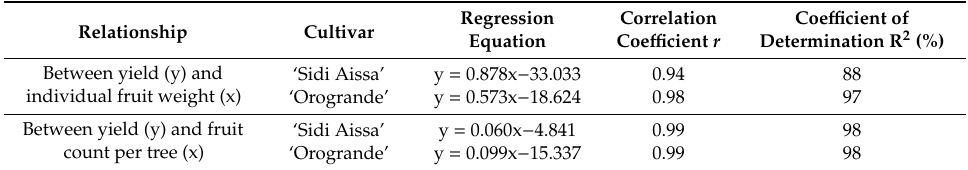
Table 5. Linear regression analysis between yield (y; tons ha − 1 ) and individual-fruit weight (g fruit − 1 ) and fruit counts per tree for ‘Sidi Aissa’ and ‘Orogrande’ clementines.